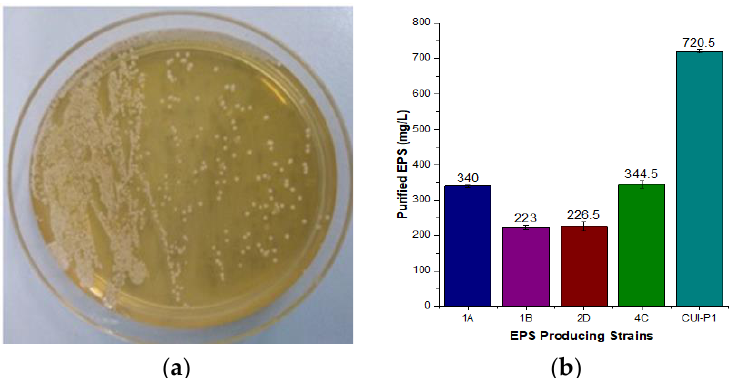
Figure 1. ( a ) Colony morphology of EPS producing CUI-P1 Acinetobacter sp. and ( b ) EPS yield of five cryoprotectant strains isolated from Passu and Pisan glaciers of Pakistan.